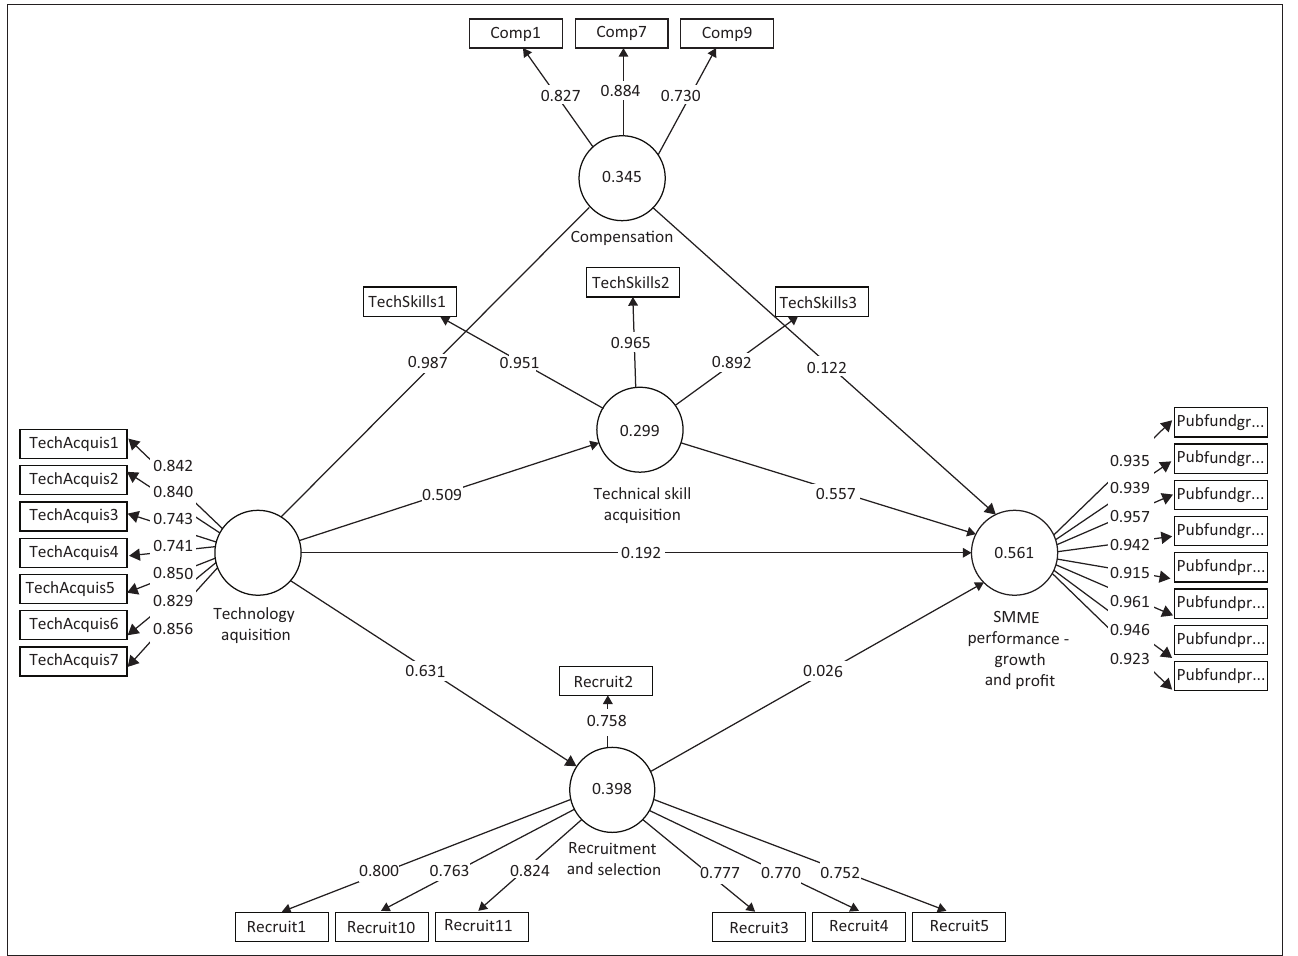
Technical skill